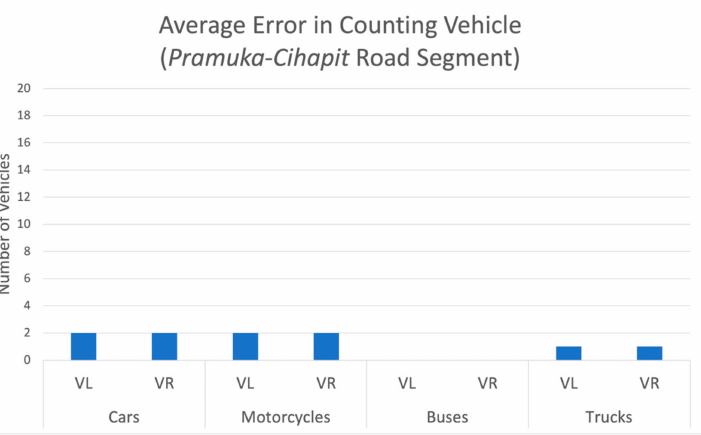
Figure 14. Average error value for vehicle counting on Pramuka–Cihapit road segment. The average errors on the Pramuka–Cihapit road segment included two cars, two motorcycles, and one truck for both lanes. Meanwhile, there were no buses when the measurement was conducted. The error is caused by several reasons, such as: (1) the CCTV’s resolution is too low and incorrectly detected the vehicle; (2) the vehicles are moving too fast; (3) there was a misclassification when detecting the type of vehicles